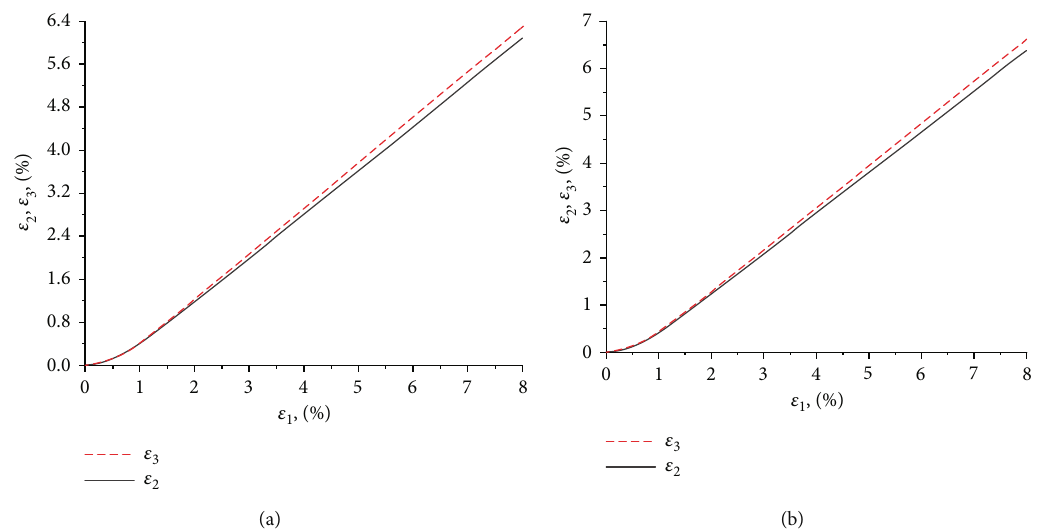
θ =30 ° ; (b) θ =60 ° . 3 =200KPa): (a)